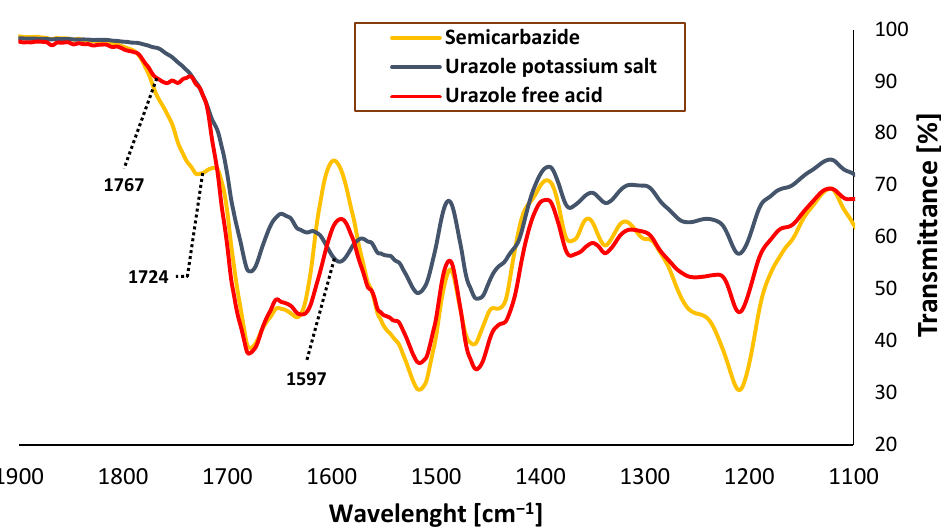
Figure 3. FT-IR spectrum of urazole-potassium gel, urazole free acid gel and semicarbazide gel.